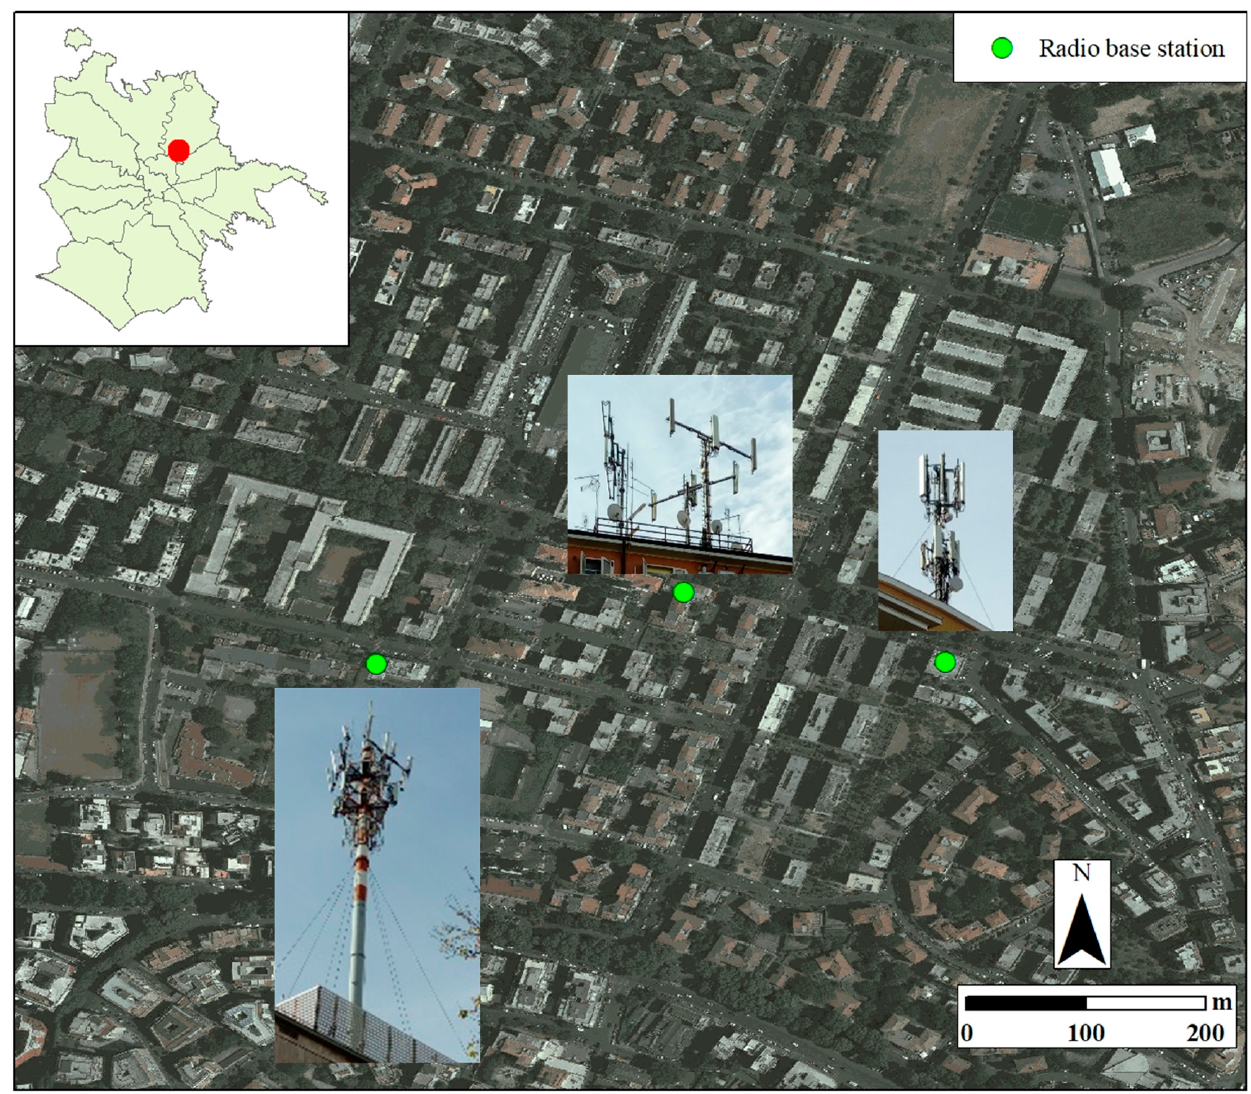
Figure 8. Geolocalization of three different (probable) RBSs—which constitute the vertex of an imaginary obtuse-angled triangle—in a sector of north-east Rome and their photos obtained during the field surveys. Source: authors’ elaboration.